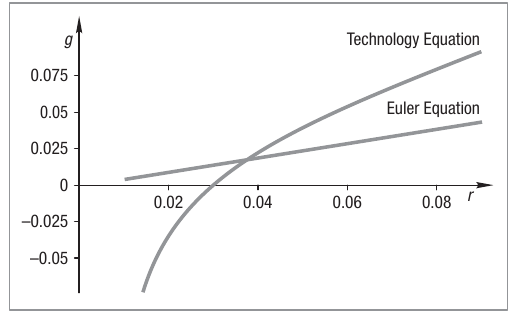
Fig. 1. BGP general equilibrium solution